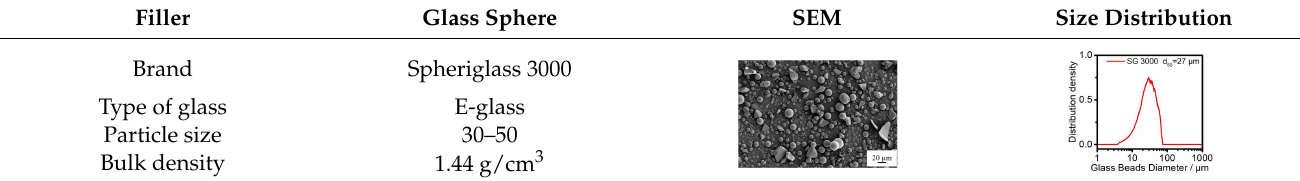
Table 2. Glass sphere.